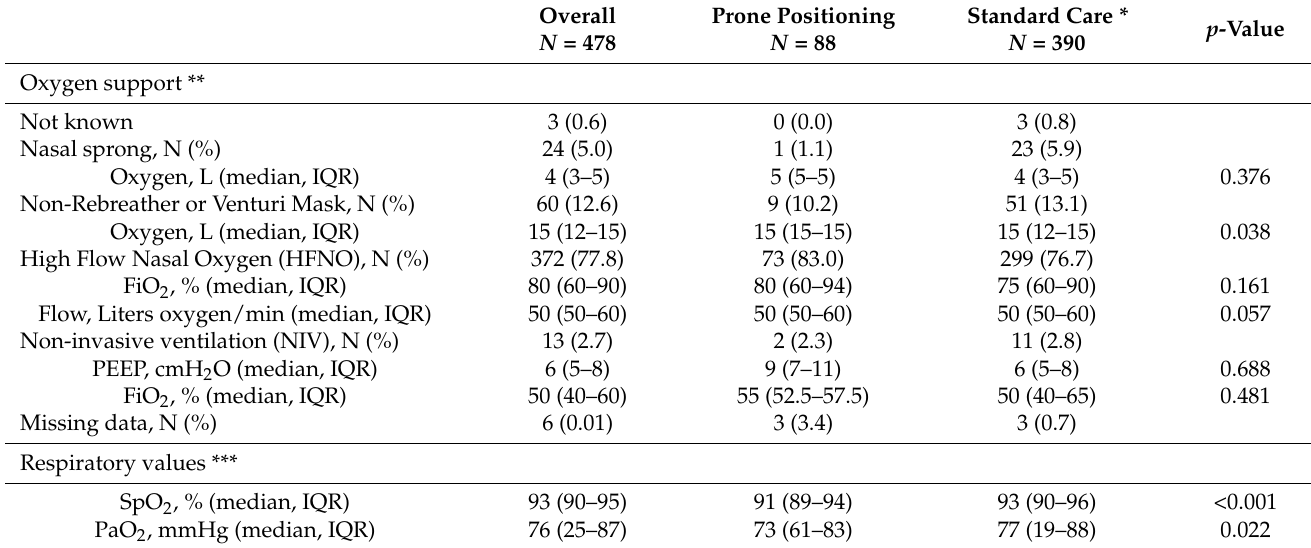
Table 3. Oxygen supplementation and characteristics at ICU admission day.